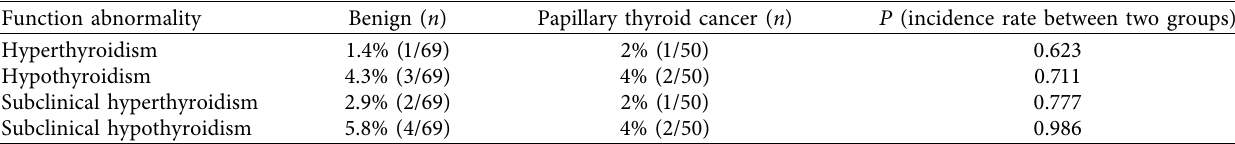
Table 3: Incidence rates of thyroid function abnormalities after microwave ablation of thyroid